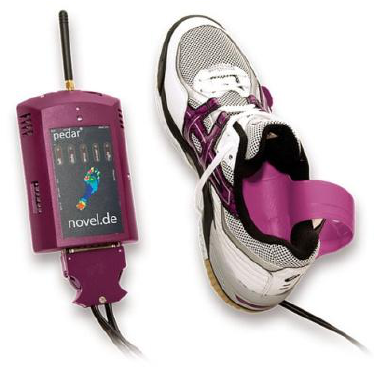
Figure 3. An in-shoe based foot plantar pressure sensor by Pedar © Novel